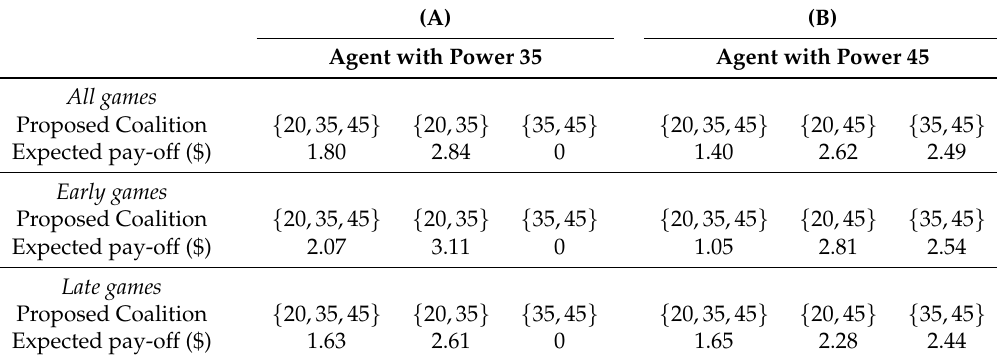
Table 4. Expected payoffs by proposal